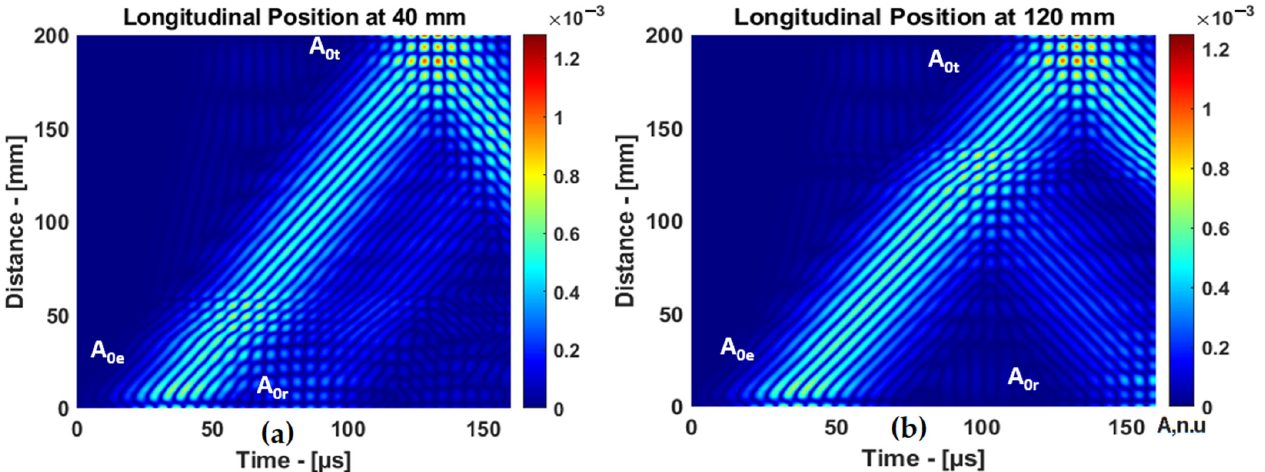
Figure 7. The B-scans of A 0 mode reflected from delamination at different positions: ( a ) delamination at 40 mm and ( b ) delamination at 120 mm.